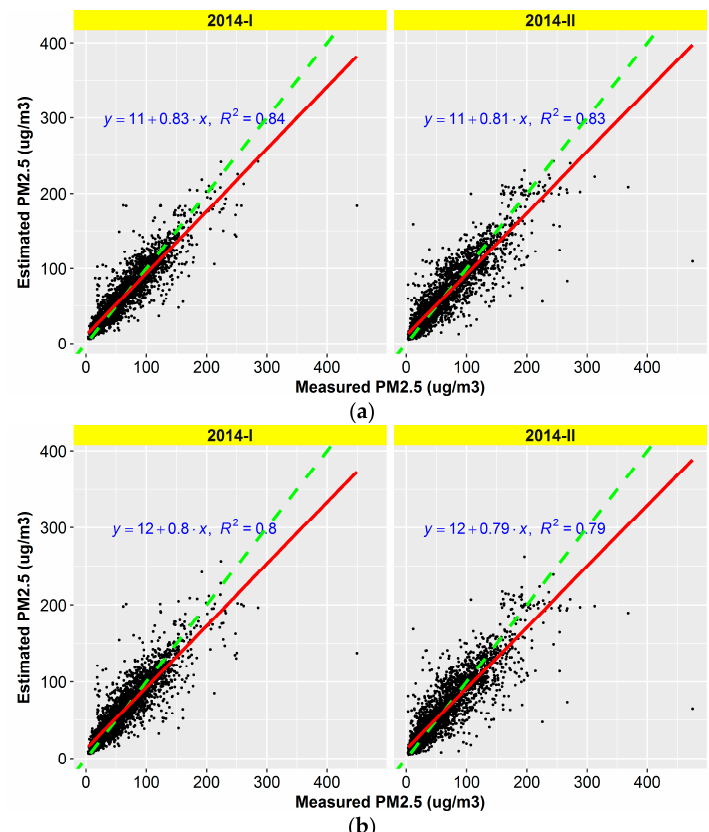
Figure 4. Boxplot statistics of the PM 2.5 estimation performance at each site in terms of R 2 , Intercept, Slope, RMSPE ( μ g/m 3 ), MPE ( μ g/m 3 ) for 3 km MOD-3K AOT: ( a ) Model fitting; ( b ) Model validation. ‘I’ denotes models using the PM 2.5 24 h average, and ‘II’ denotes models using the PM 2.5 period average.